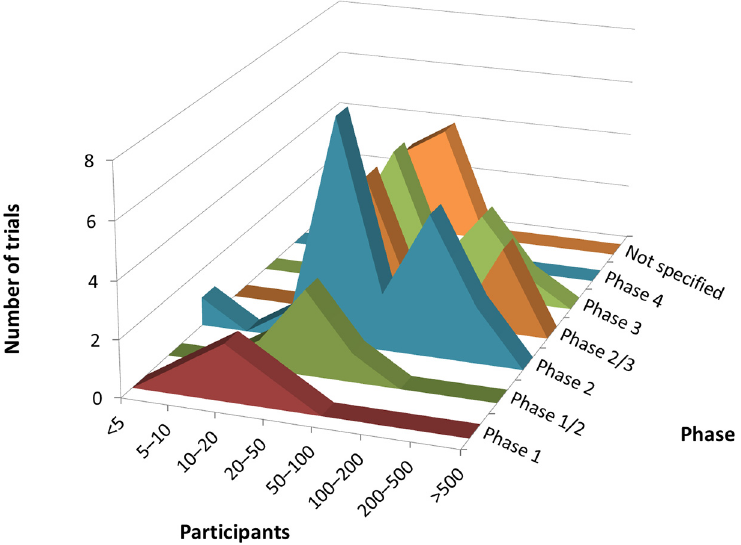
Fig 7. Cross-analyses between trial participants and phase in Japanese registries. Curve areas represent the number of trials across phase and the